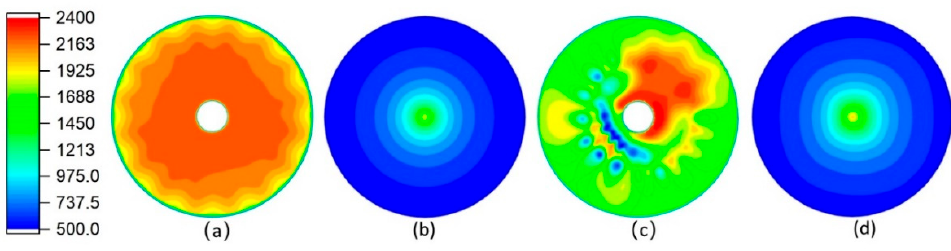
Figure 4. Temperature fields formed using different mesh cells. ( a , c ) Temperature field at the middle section of the combustion chamber; ( b , d ) temperature field on the surface of the substrate. ( a , b ) The fourth meshes are adopted; ( c , d ) the first meshes are adopted (the pictures are scaled to different degrees).